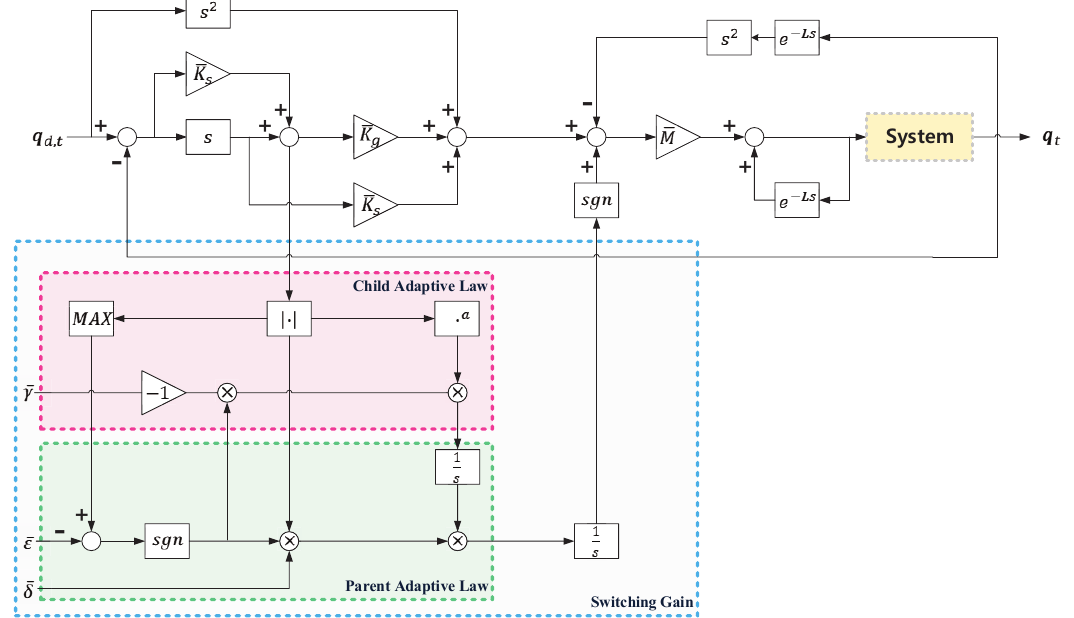
Figure 1. A block diagram of the proposed strong and stable adaptive sliding-mode control (SS-ASMC)